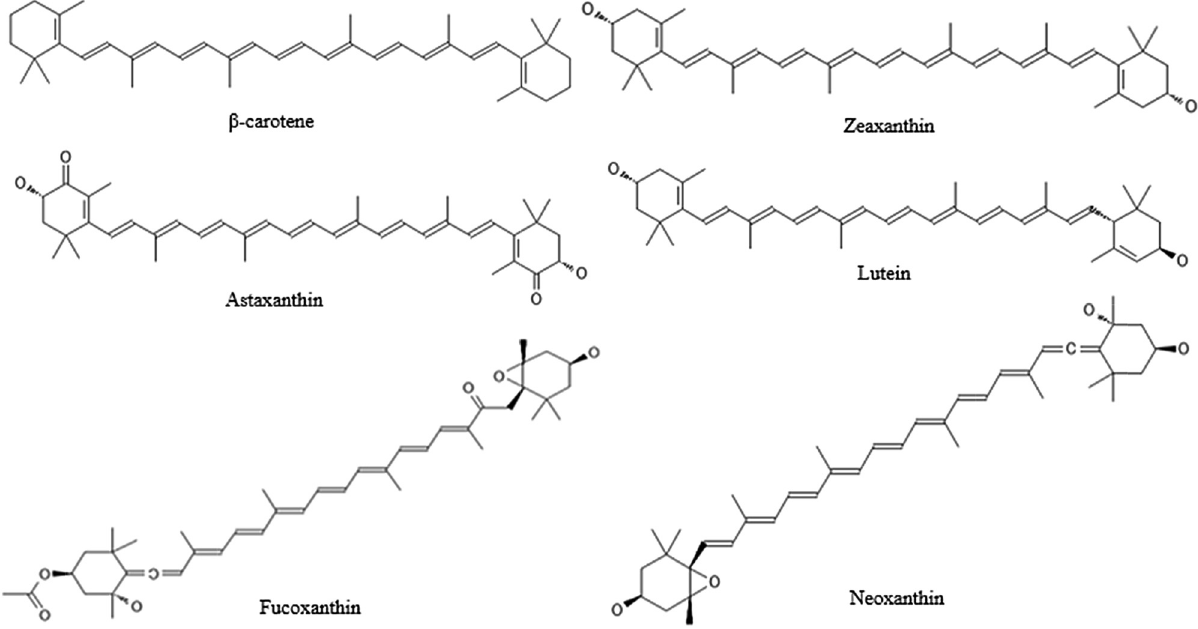
Figure 2: Chemical structure of carotenoids: carotenes ( β - carotene ) and xanthophylls ( Astaxanthin, Fucoxanthin, Zeaxanthin, Lutein, and Neoxanthin )